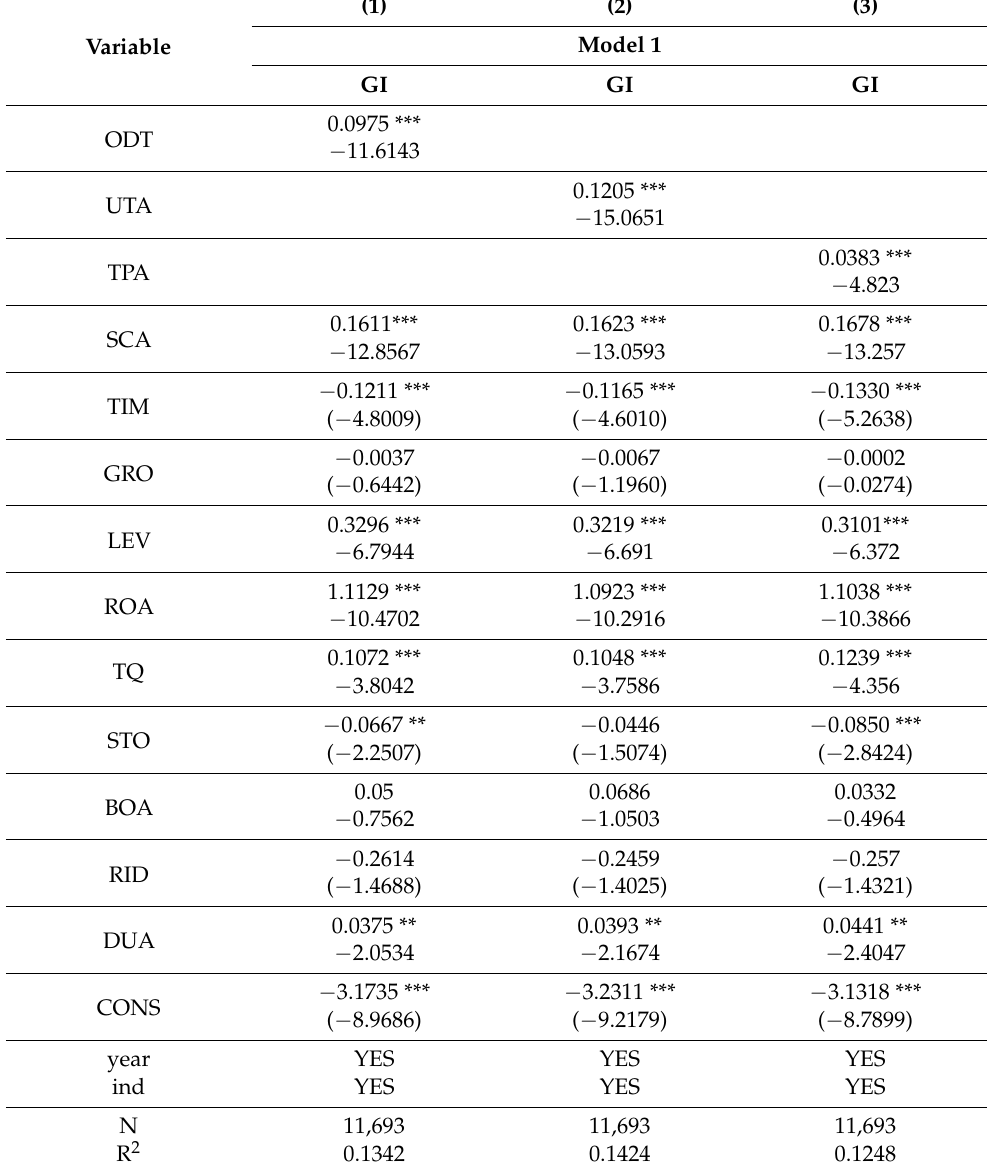
Table 3. Empirical results of digital transformation and green